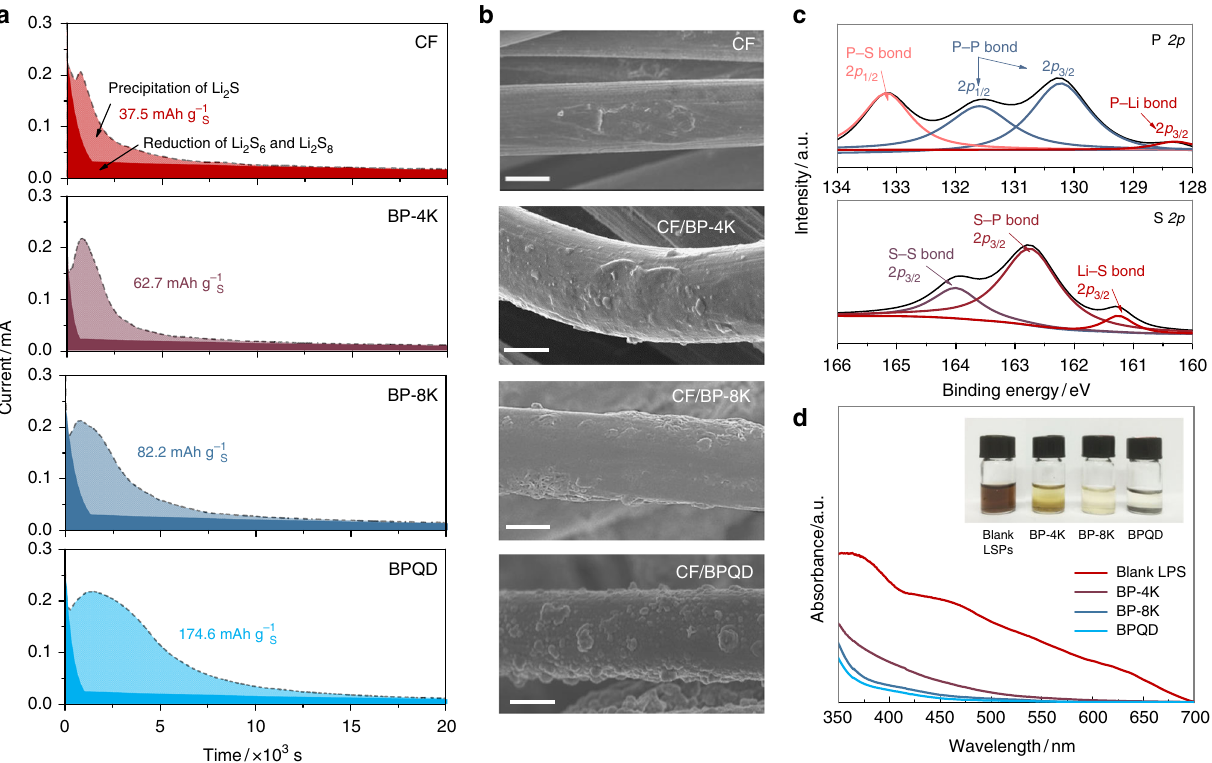
Fig. 2 Black phosphorus fl akes for lithium polysu fi de conversion and adsorption. a Potentiostatic discharge curves of Li 2 S 8 tetraglyme solution on different substrates at 2.05 V. The dark/light colors indicate the reduction of Li 2 S 8 /Li 2 S 6 and the precipitation of Li 2 S, respectively. b scanning electron microscopy (SEM) images showing the precipitation of Li 2 S on different substrates as indicated in a , c X-ray photoelectron spectroscopy (XPS) spectra for P 2 p and S 2 p of the black phosphorus (BP) fl akes adsorbed with lithium polysul fi des (LiPSs), d ultraviolet – visible (UV – vis) spectra of LiPS with variation in color upon adsorption by different-sized BP fl akes. Scale bar, 5 µ m ( b ). (CF is carbon fi ber, BP-4K is BP that was centrifuged at 4000 rpm, BP-8K was centrifuged at 8000 rpm, BPQD is black phosphorus quantum